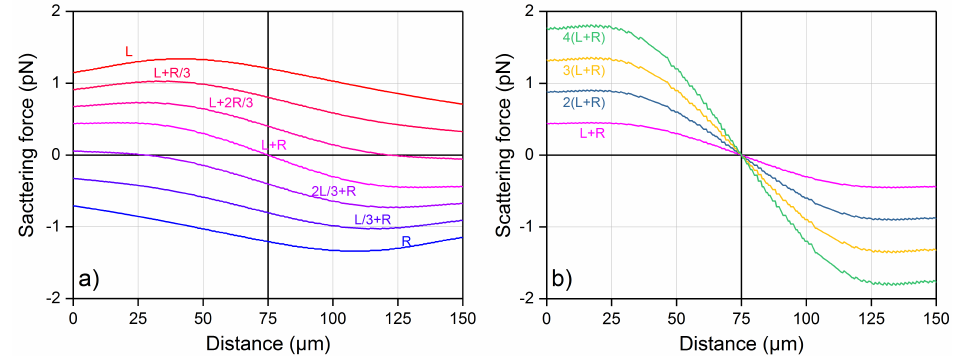
Figure 6. Total scattering force, as a function of the position inside the microchannel, produced by two facing laser beams on a PMMA bead of 10 µm diameter suspended in water. The laser power values are varied by multiplying 10 mW times the factor indicated by the curve labels. Capital letter “L” stands for the left laser beam and “R” for the right